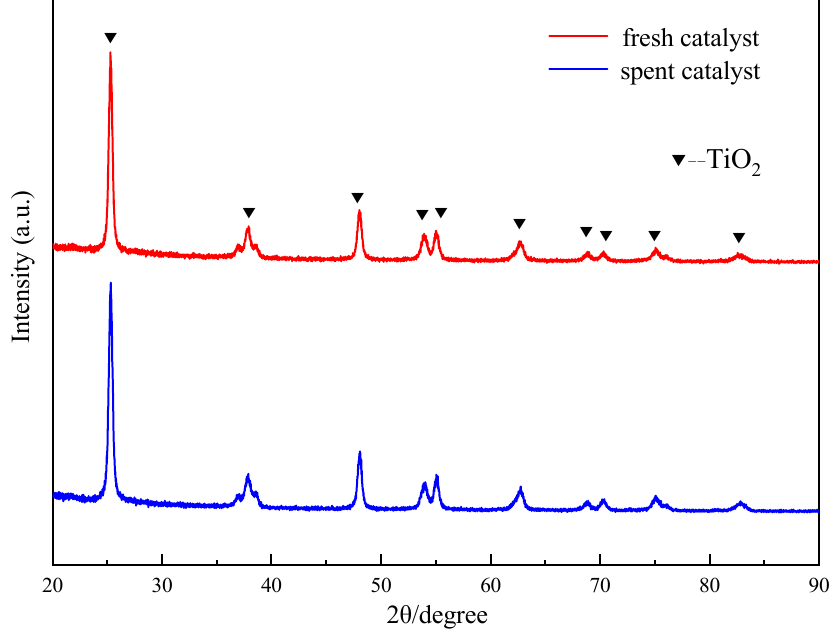
Figure 1. XRD patterns of denitration catalyst before and after deactivation.